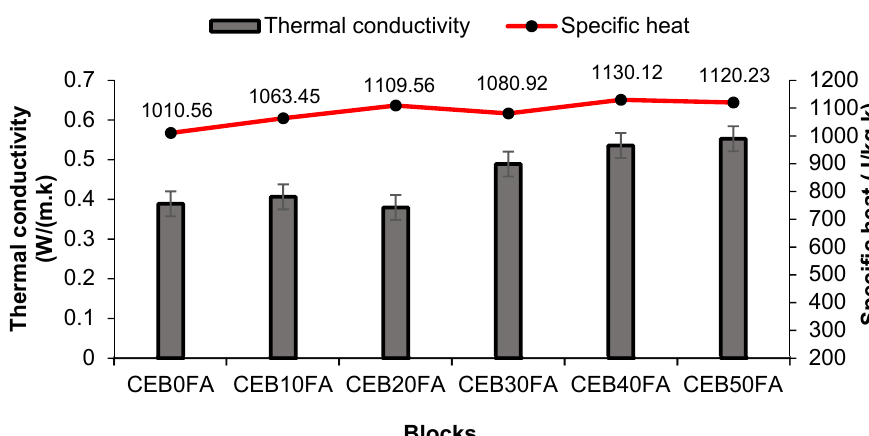
Ɛ = -1.99x + 41.347 R² =